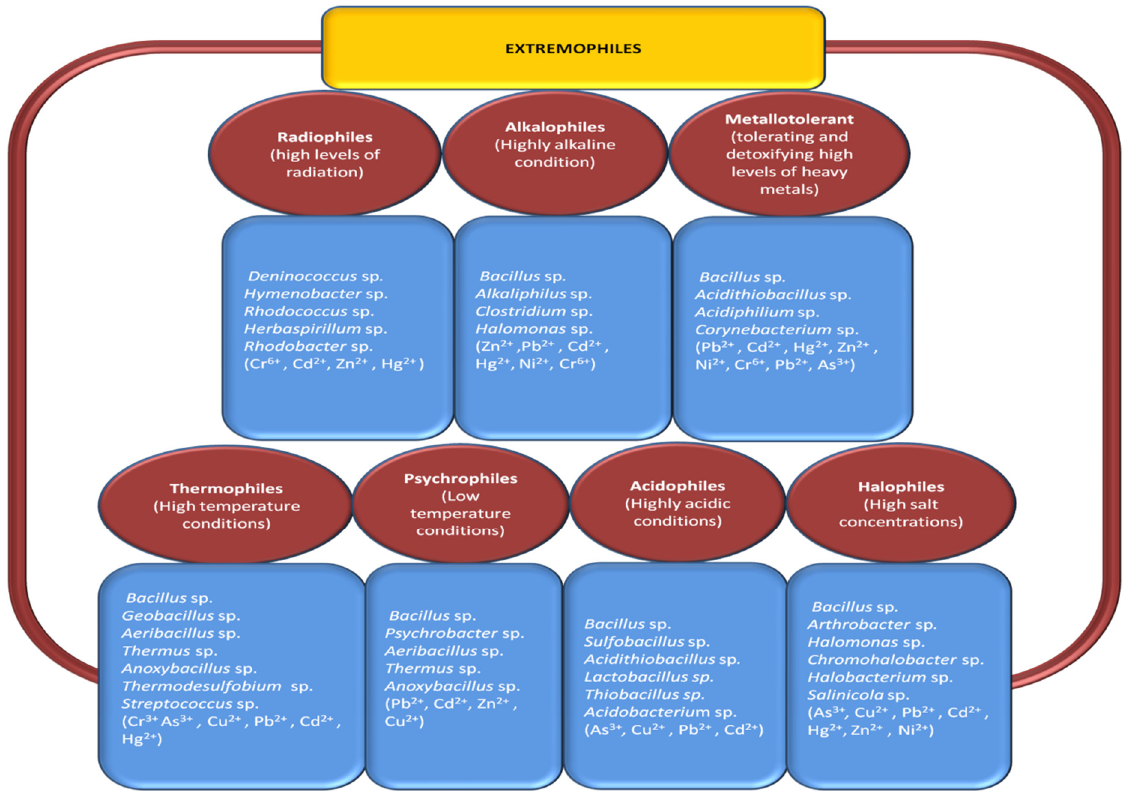
Figure 3. A schematic diagram representing extremophile candidates tolerant to different harsh environmental conditions that are capable of heavy metal removal.